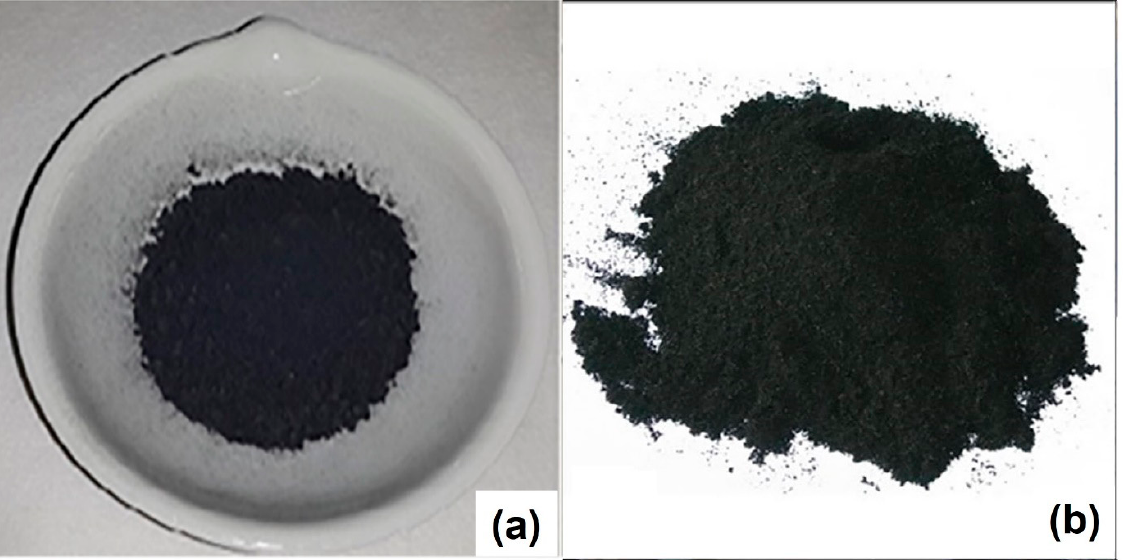
Figure 1. ( a ) Polypropylene-waste-derived char potentially used as an additive for producing epoxy composite. Reprinted from Sogancioglu et al. [41], Copyright (2019), with permission from Springer Nature. ( b ) Tire-waste-derived char potentially used as an additive for producing epoxy composite. Reprinted from Verma et al. [42], Copyright (2019), with permission from Wiley.